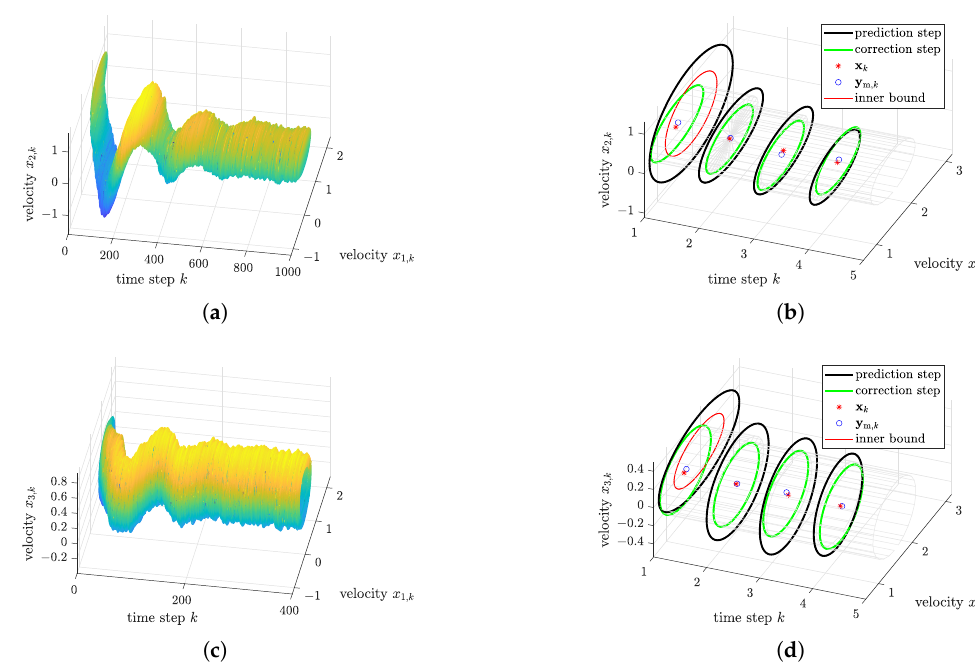
Figure 10. State estimation for the case of large uncertainties (91). ( a ) Outer ellipsoidal enclosures for the velocities x 1, k and x 2, k . ( b ) Enlarged view of the ellipsoidal enclosures of x 1, k and x 2, k . ( c ) Outer ellipsoidal enclosures for the velocities x 1, k and x 3, k . ( d ) Enlarged view of the ellipsoidal enclosures of x 1, k and x 3, k .